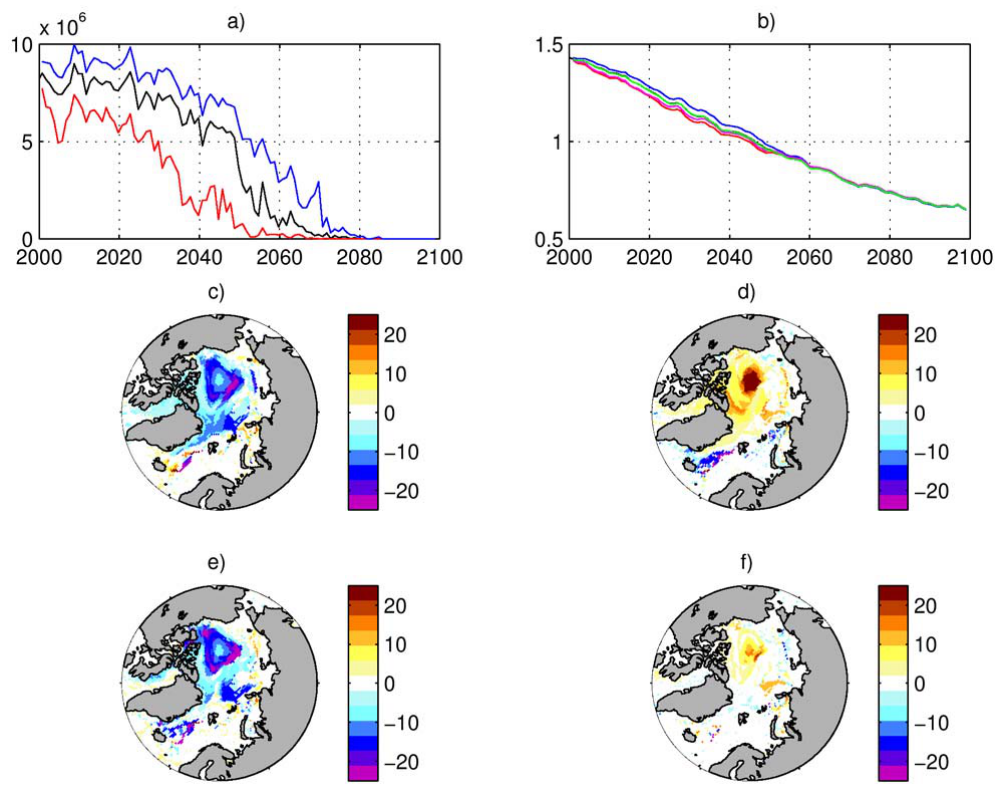
Fig. 8. Time evolution of the modelled characteristics for the Arctic Ocean (treated here as poleward of 66 ◦ N): (a) extent of the Northern Hemisphere sea ice (September averaged, km 2 ); (b) (cid:127) a for the control run (black); fast (red) and slow ice decline (blue); high (green) and low (magenta) diffusivity experiments; (c–f) : difference in the date (years) of the first occurrence of undersaturated conditions in respect to aragonite between the control run and the following numerical experiments: fast (c) , slow (d) ice decline; low (e) , high (f) diffusivity. Negative numbers denote earlier undersaturation onset dates than in the control